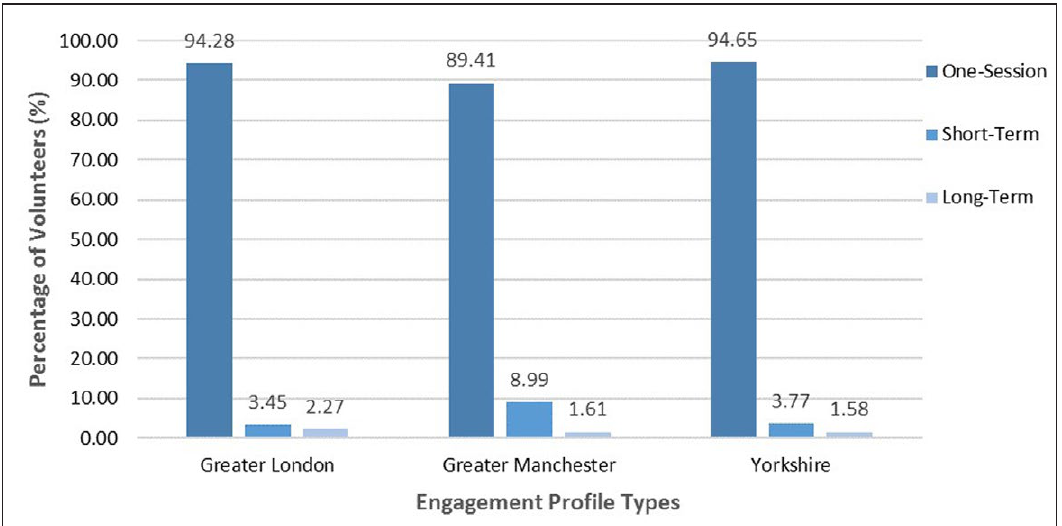
Figure 3: Percentage proportions of volunteers who contribute to each engagement profile type across regions.